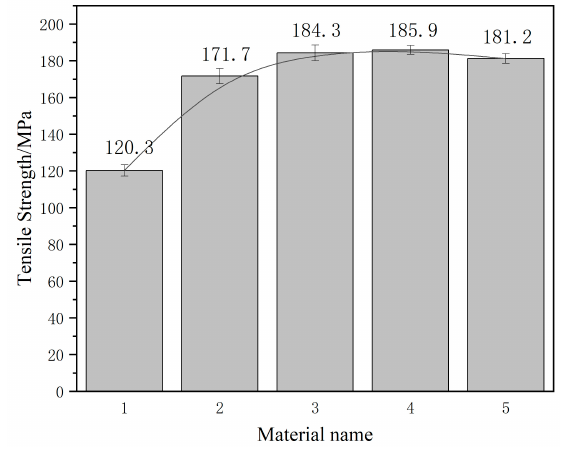
Figure 10. Tensile strength of Al–20Si with different additions.